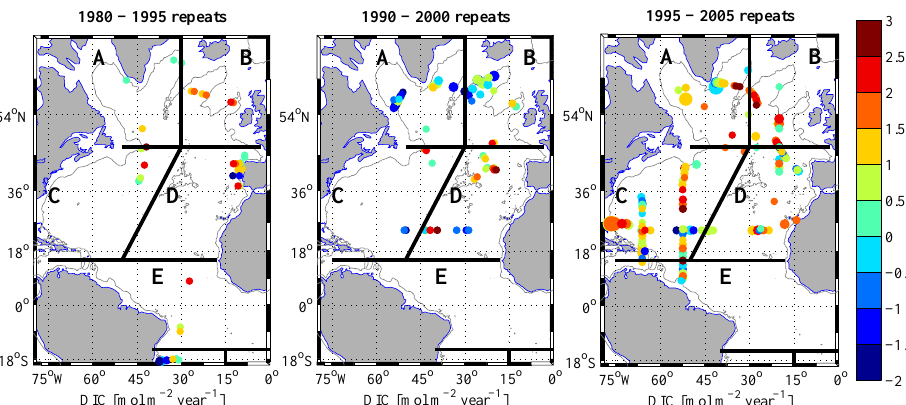
Fig. 7. Storage rates for DIC for three different time periods. Left panel – storage rates for repeats where both cruises were conducted between 1980 and 1995; middle panel – both repeats were conducted between 1990 and 2000; right panel – both repeats were conducted between 1995 and 2005. The 2000m isobath is marked with a gray thin line.